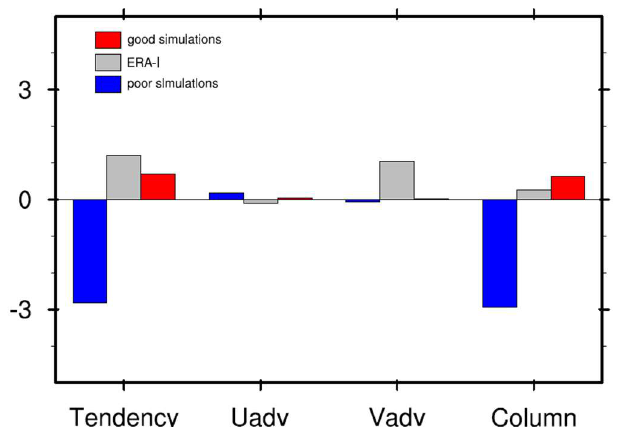
Figure 14. Results of the regressed moisture budget analysis in observation, good and poor simulations. Four terms presented are defined in Yanai et al. [86]. Each term is regressed against the time series of area-averaged 20–100 day filtered OLR in the reference area (5° S–5° N; 75°–85° E) and then vertically integrated from surface to 100 hPa. The integrated four terms are averaged in the pre-moistening area (10° S–10° N; 90°–120° E) in observation, good and poor simulations.